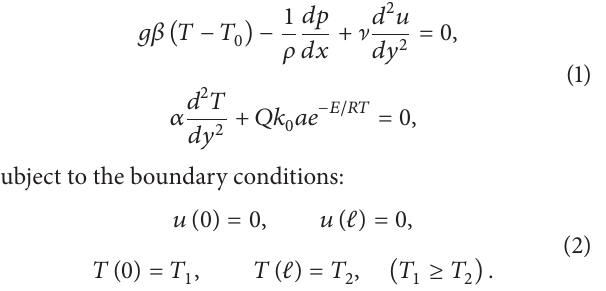
Figure 1: Schematic representation of the